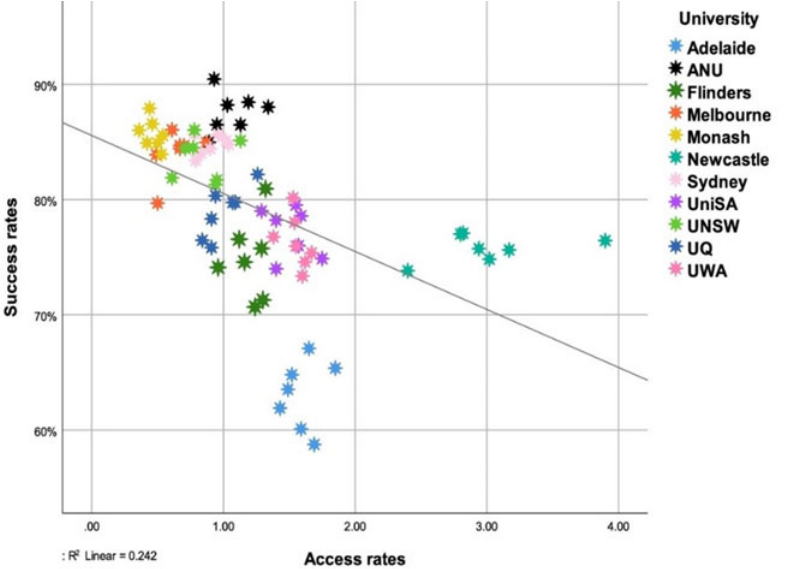
Fig. 2. Success rate v access rate 2009 – 2015 (11 universities, 77 data